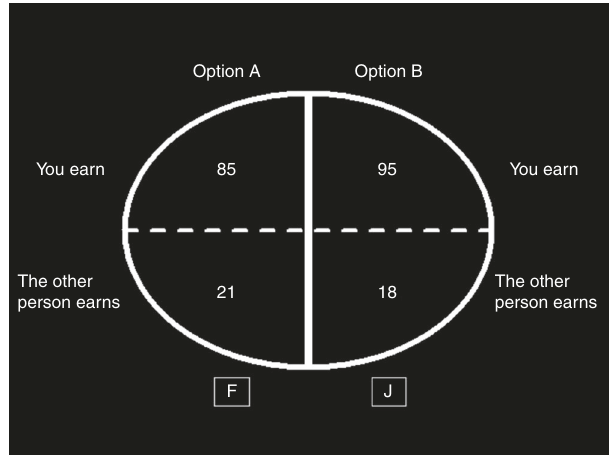
Fig. 1 Screenshot of the mini-dictator game in the time-free condition. In this game, the subject can either press key “ J ” to choose the sel fi sh option (Option B) which has a higher payoff for herself (95 vs. 85 in this example) or press key “ F ” to choose the pro-social option (Option A) which has a higher payoff for the other participant (21 vs. 18 in this example). The text is enlarged for display purposes. Refer to Supplementary Fig. 1 for